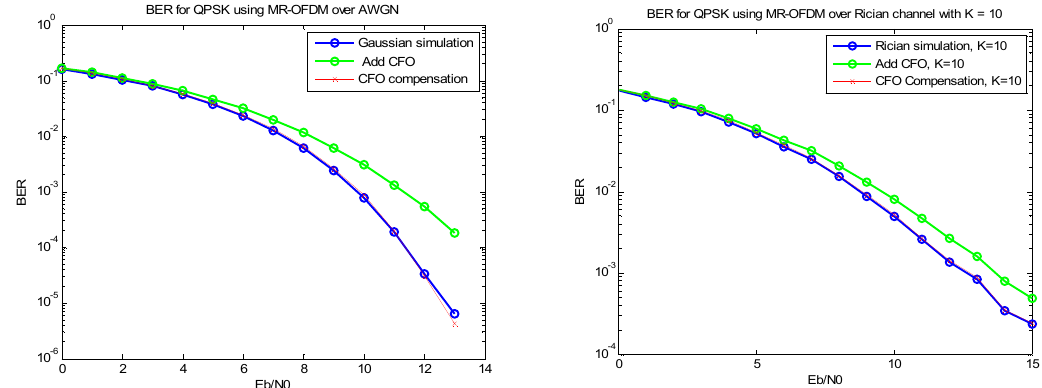
Figure 10. Simulation BER per Eb / N0 of MR-OFDM over the Gaussian and Rician channels with the acceleration of a = − 0.5 m / s 2 . BER for QPSK using MR-OFDM over Rician channel with K = 10 Rician simulation, K=10 Add CFO, K=10